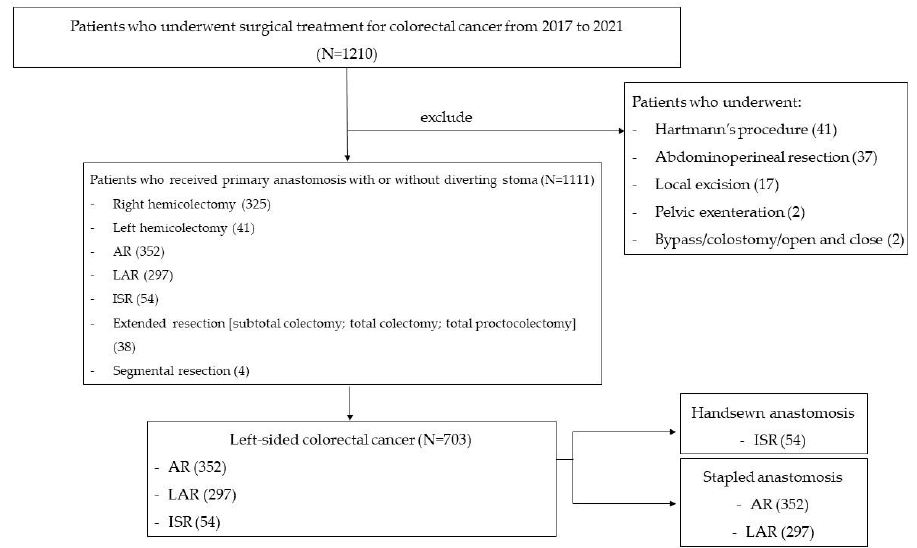
Figure 1. Patients flow chart. Abbreviations: AR, anterior resection; LAR, low anterior resection; ISR, intersphincteric resection